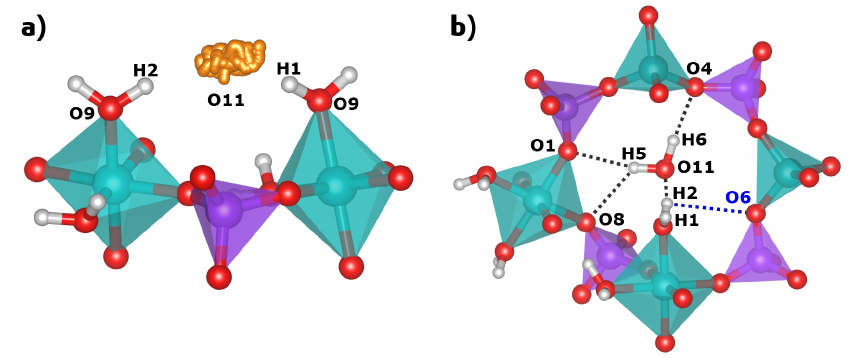
Figure 7. ( a ) Evolution of the position of one O11 atom (H 2 O(pore) molecule) during the 7.5 ps covered by the AIMD simulation. ( b ) Local environment of the H2 atom in the PBE-TS optimised structure. The contact to the O6 framework atom is shown in